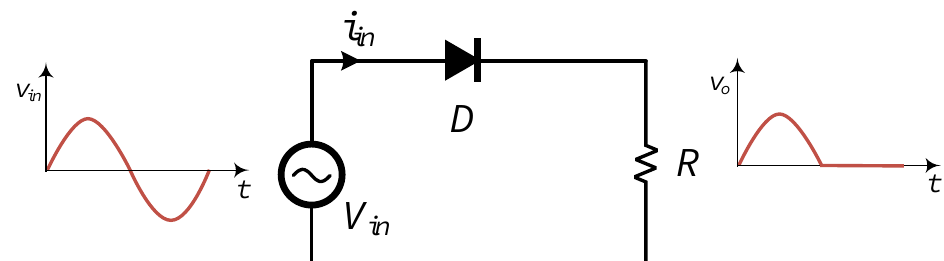
Figure 5. Single-phase half-wave